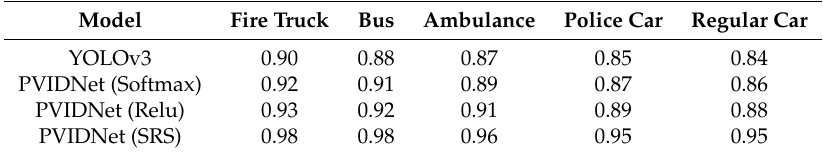
Table 10. Accuracy results of the machine learning algorithms classifying the images of Fire Trucks, Buses, Ambulances, Police Cars, and Regular Cars in the training phase considering together the right, left, and front images.